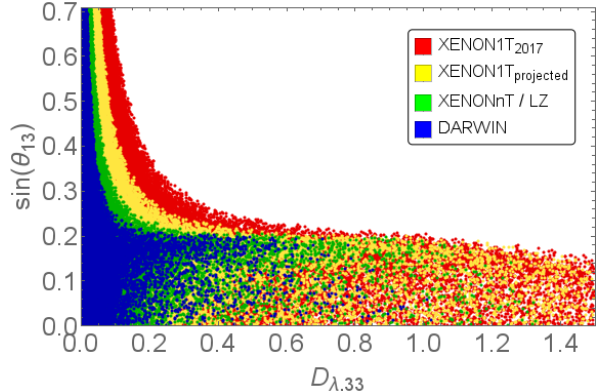
Figure 6 . Viable areas of parameter space of the quark doublet DMFV model, for di(cid:11)erent WIMP nucleon scattering cross section limits, for DM mass m (cid:31) = 250 GeV and mediator mass m (cid:30) = 850 GeV. The current exclusion bounds of XENON1T [43], as well as the projected bounds of XENON1T [45], XENONnT [45], LUX-ZEPLIN (LZ) [46] and DARWIN [47] have been imposed respectively. Note that in this scan we did not impose any of the other constraints discussed before, as we focus on the bare in(cid:13)uence of the direct detection